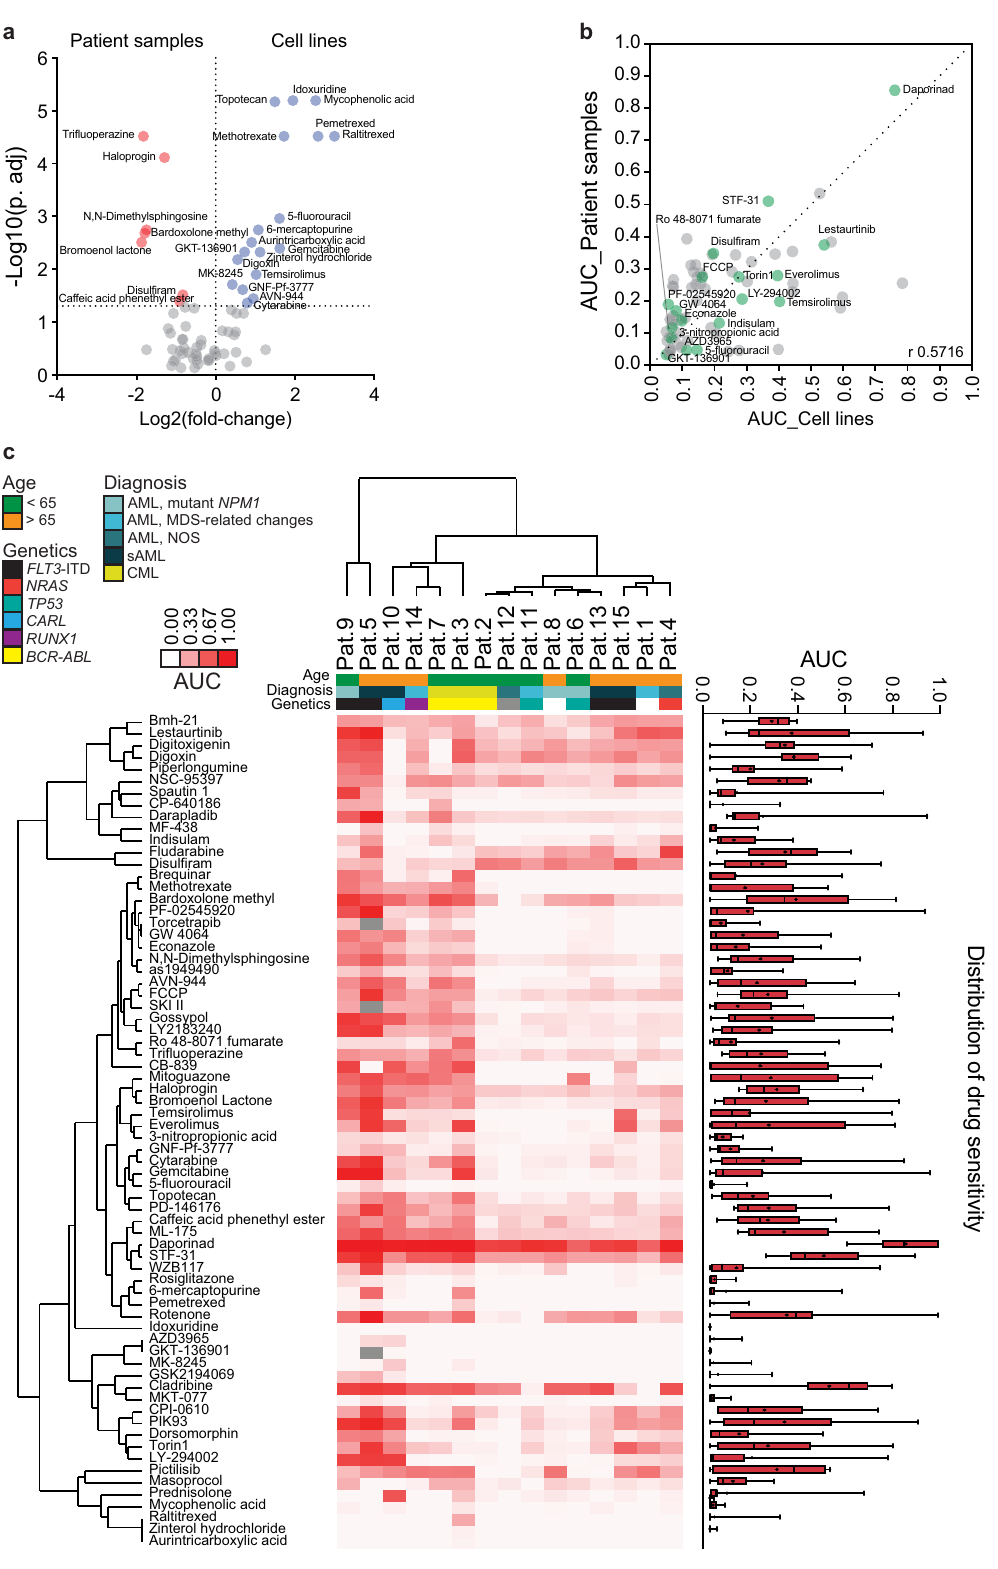
was subtracted from the AUC value of the drug in each individual cell line and visualized with a spider plot using R statistical environment. Evaluation if metabolic inhibitors can alter metabolic vulnerabilities was performed by rescreening the entire drug library as described above (each drug tested in fi ve different concentrations in duplicate) in HL-60 cells in the presence of either DMSO, 100 nM AZD3965, 100 nM pictilisib, or 100 nM GSK2194069. Data analysis was the same as for the original screen with overall drug response pro fi